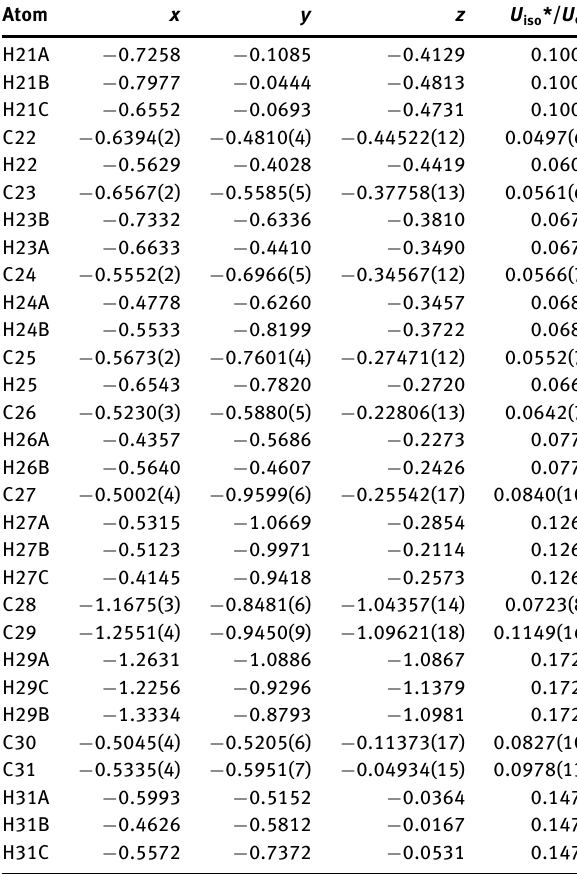
Table 2: Fractional atomic coordinates and isotropic or equivalent isotropic displacement parameters (Å 2